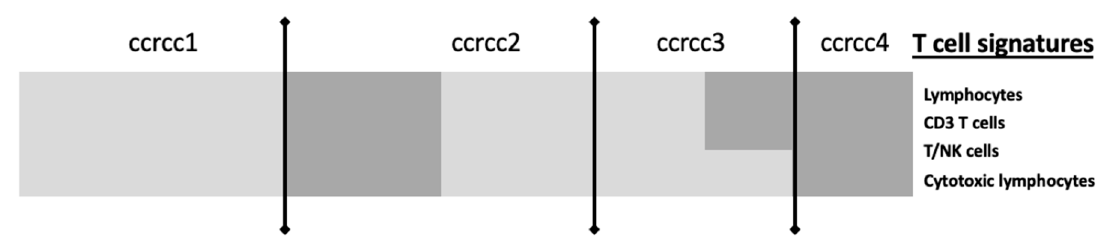
Figure 3. Simplified view of T-cell signatures according to the ccRCC molecular subgroup, adapted from The Human Tumor Microenvironment, Vano et al. Oncoimmunology 2018 [95]. Legend: ccrcc molecular subgroups have different gene expression immune profiles. Ccrcc 1 are immune-desert, ccrcc 4 are immune-high, ccrcc3 are immune-competent and ccrcc 2 immune-mixed. Light grey means Underexpression; Dark grey means Overexpression.